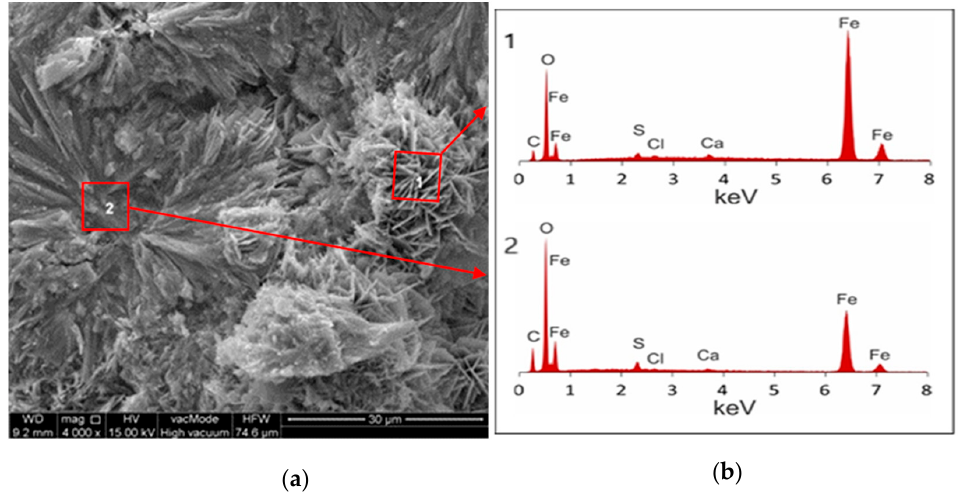
Figure 8. Morphology of the outer layer of the sediment on a corroded cast-iron pipe: ( a ) SEM micrograph; ( b ) spectrum of chemical composition (EDS) of the sediment in points 1 and 2.